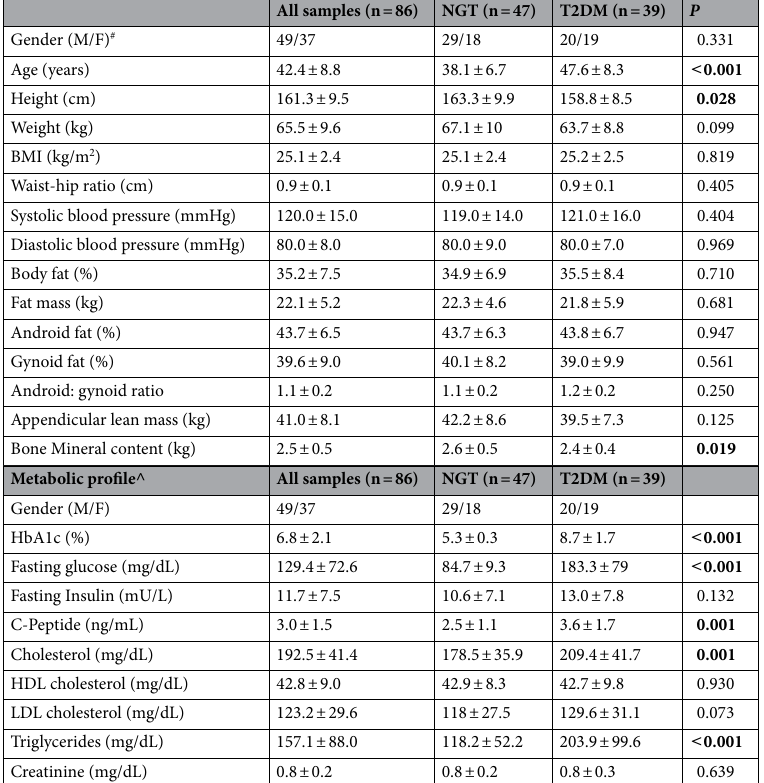
Table 1. Subject characteristics and metabolic profile of the 86 study subjects. Data presented as mean ± SD. ^Blood was drawn from fasting volunteers. P values are from the independent t-test. P ˂ 0.05 is shown in bold. # P value from Chi-square